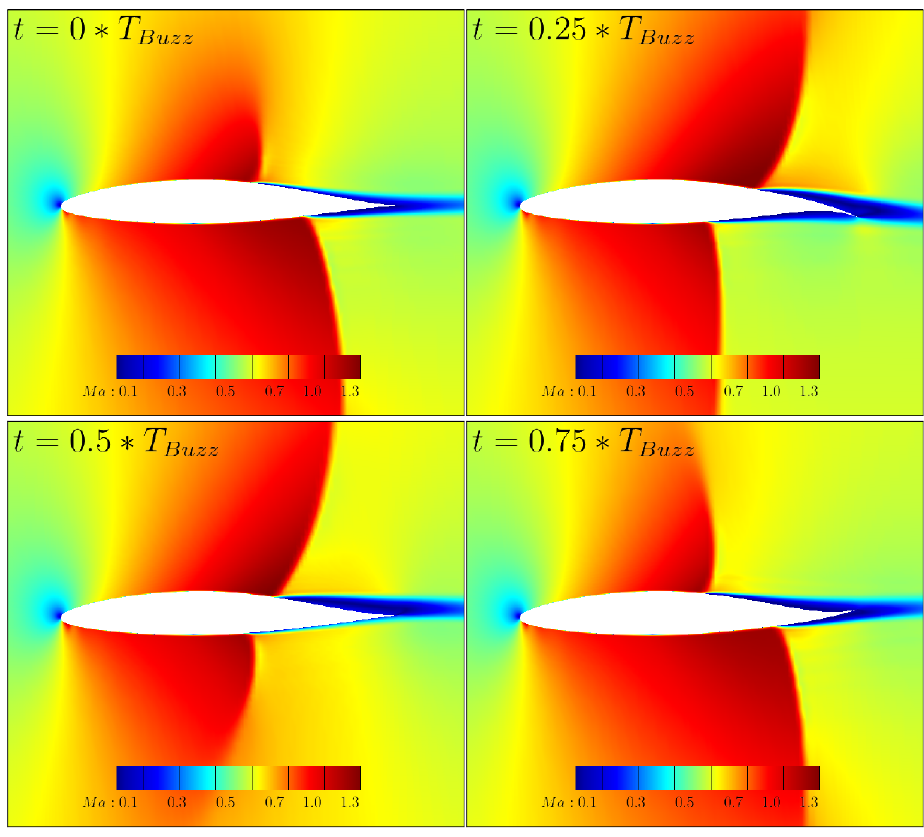
Figure 3. Mach number contour plots showing the buzz cycle of the NACA65 1 213 airfoil ( Ma ∞ = 0.82, Re = 20.7 10 6 , α = 1 ◦ , δ = 12 ◦ ). T Buzz refers to the buzz × − ±